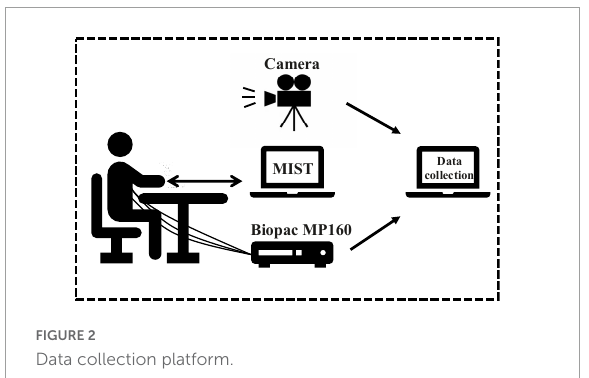
FIGURE2 Data collection